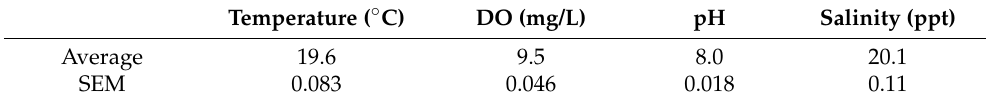
Table 1. Average water quality conditions in system over the 42-day experimental